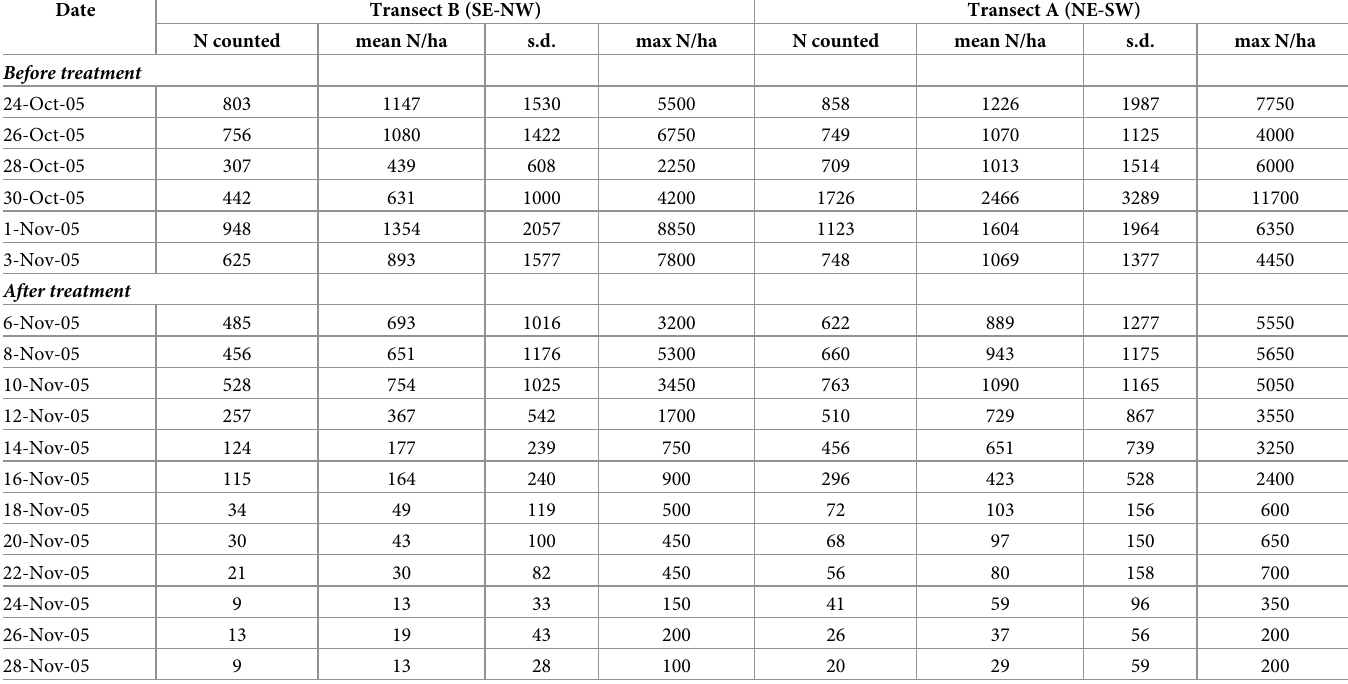
Observations of affected locusts and of avian locust predation Searches for dead locusts revealed very few, and it was obvious that dead insects rapidly disap- peared. Presumably nocturnal predation and scavenging activity was responsible for removal of dead or dying insects whereas ants, in particular, took care of the remains. Sluggish dying Table 2. Number of adult desert locusts counted on two transects and estimates of mean ( ± s.d.) and maximum number of desert locusts per ha before and after